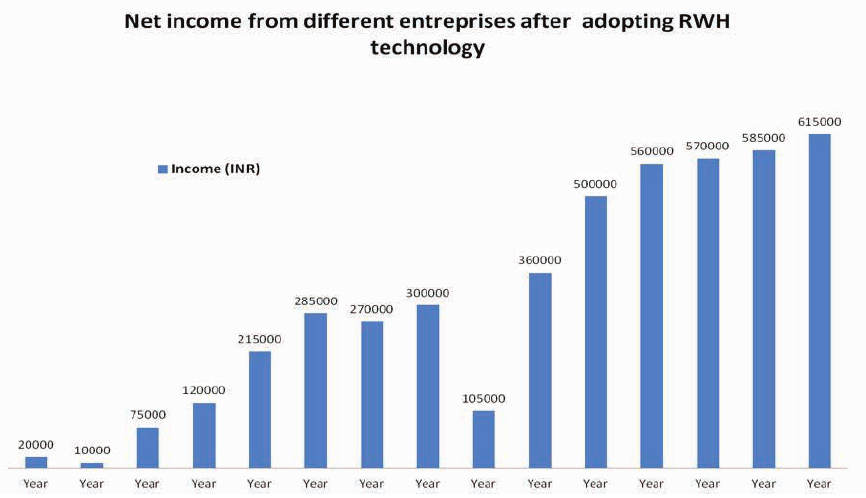
Figure 6: Net income of farmer from different